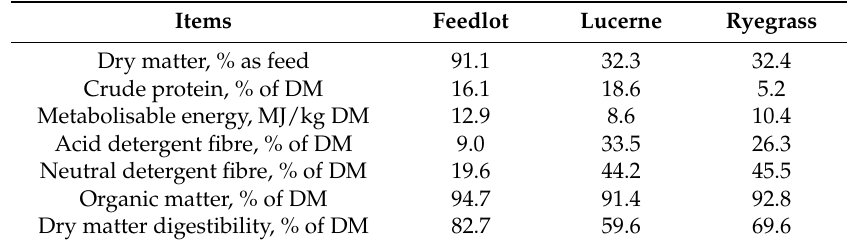
Table 1. Dry matter (DM) content and nutritive characteristics of feedlot, lucerne pasture and annual ryegrass pasture used for feeding during the experimental